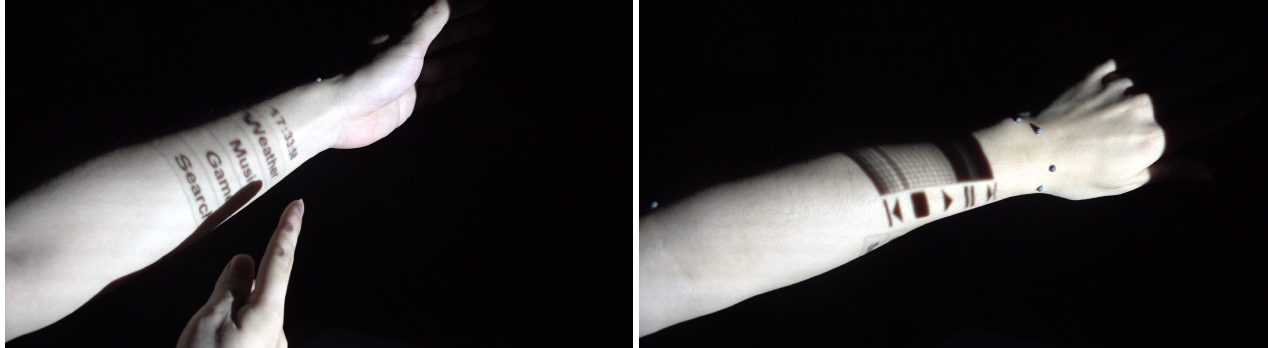
Figure 8. Proposed system projecting tattoo images (first row) onto the forearm surface under skin deformation (second to fourth rows).